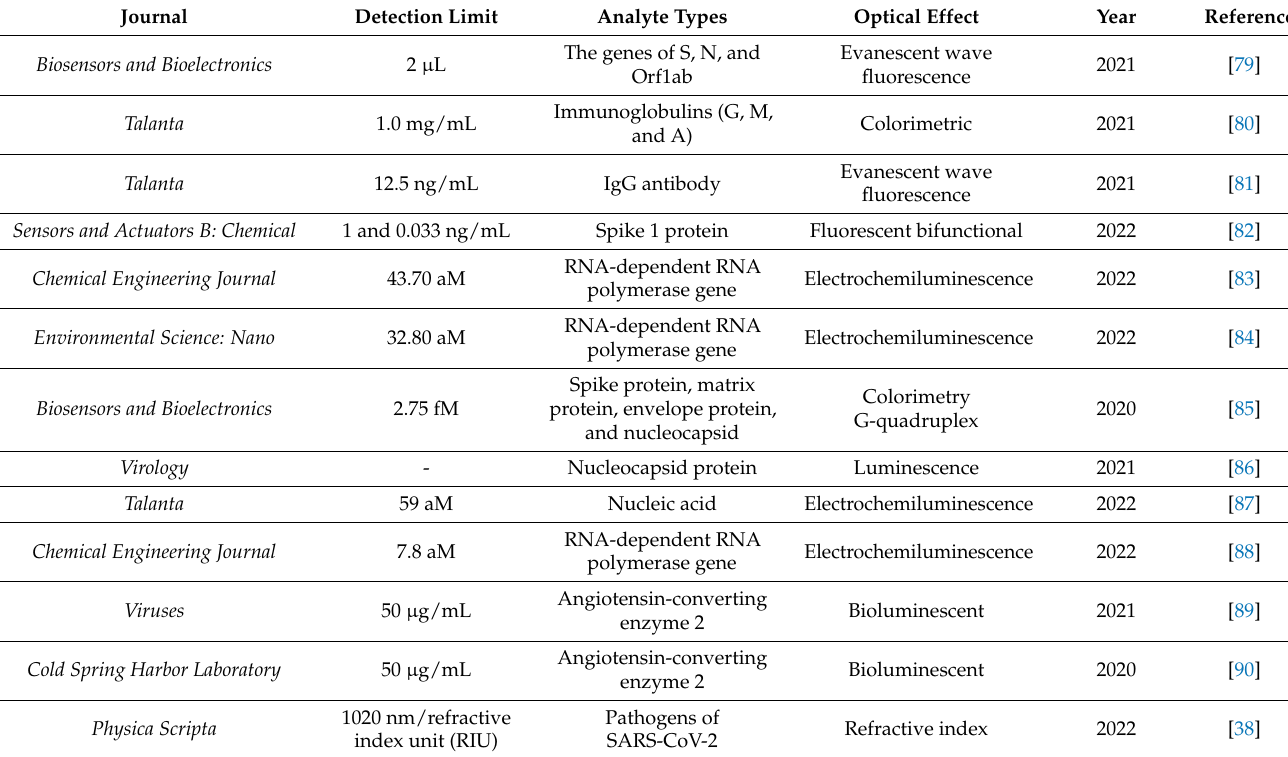
Table 1. Representative optical biosensors papers for the detection of